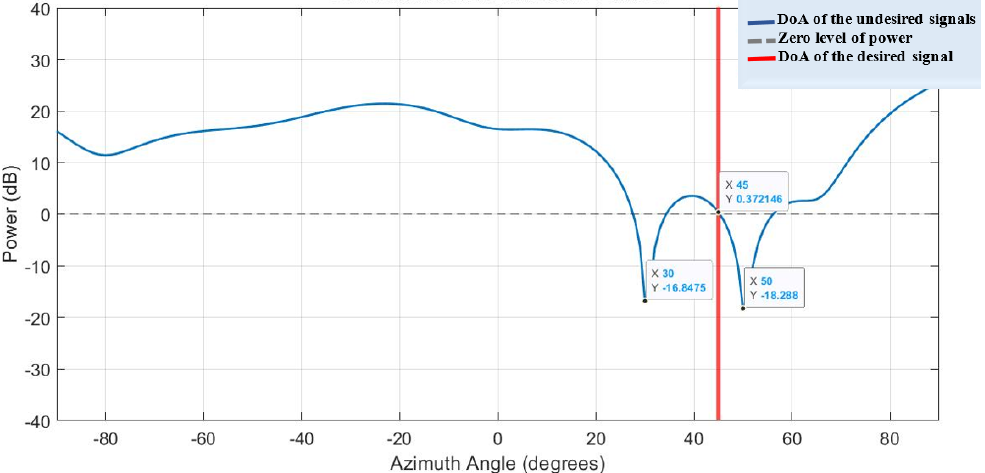
Figure 11. The spatial filtering performance of the QS-SVM-based digital beamformer on the FPGA board. The obtained results are associated with the part of the pattern plot in Figure